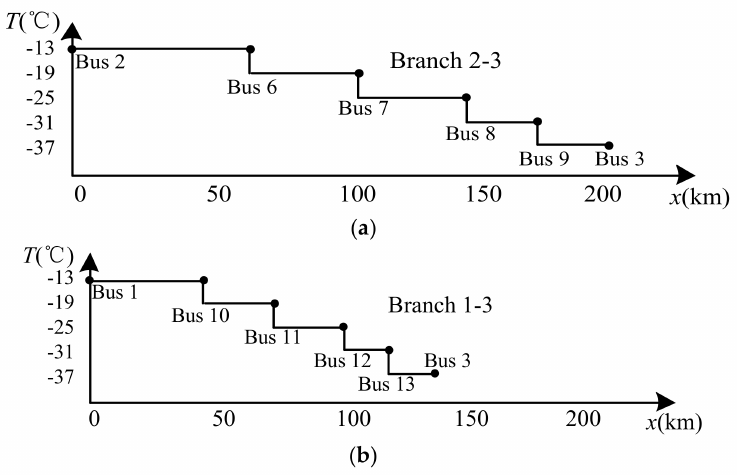
Figure 6. Segment results of ( a ) branch 2-3 and ( b ) branch